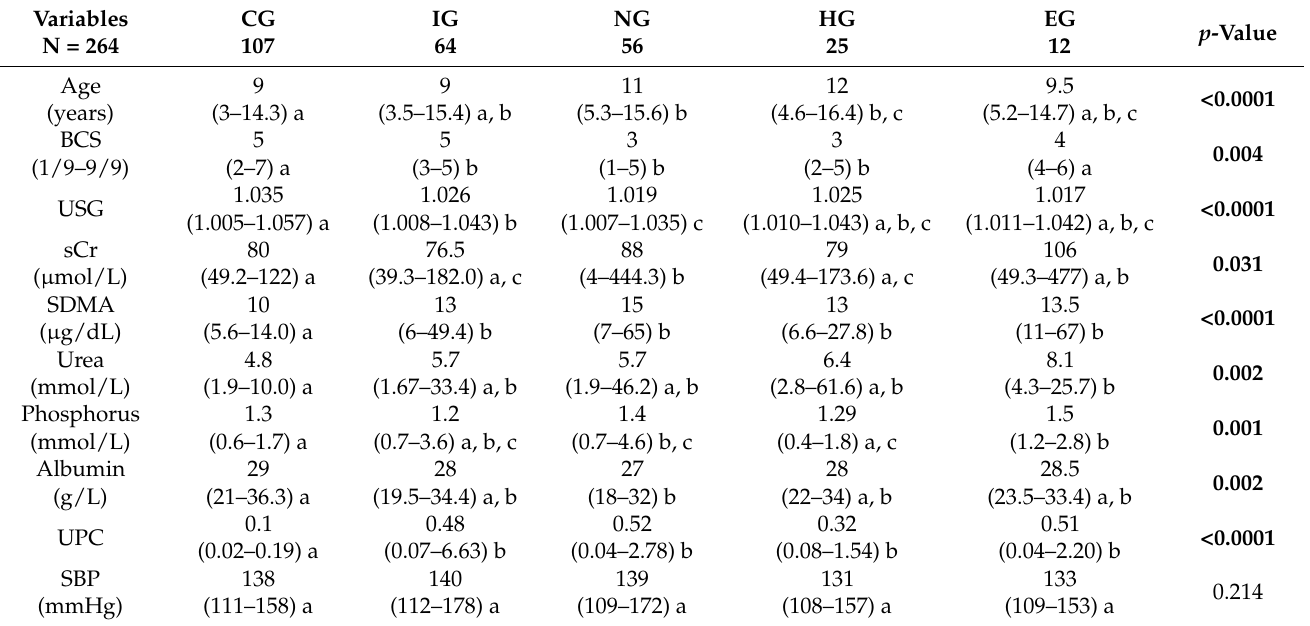
Table 2. Medians and percentiles for age, BCS, USG, sCr, SDMA, urea, phosphorus, albumin, UPC, and SBP for the groups with different